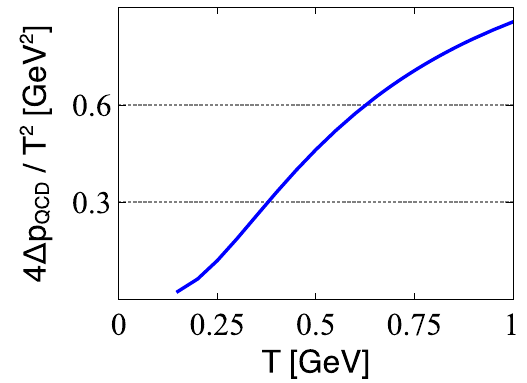
Fig. 3 Difference of the pressure densities, Δ p QCD , in the two Higgs phases as a function of temperature. We use m u , d = 4 MeV, m s = 26 m u , d and m c = 12 m s with r =